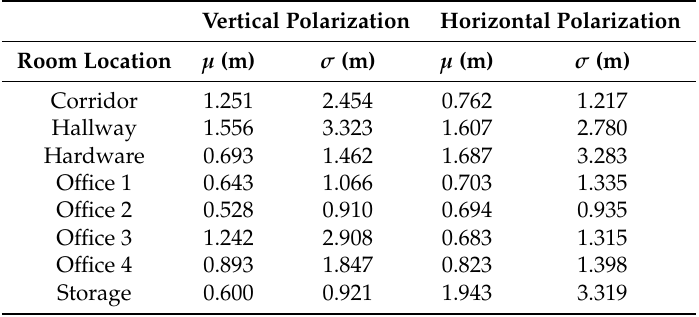
Figure 5. Localization performance of the proposed 3D CSI method when placing a TDVS receiver in each room of the simulated indoor environment for ( a ) vertical transmitter polarization and ( b ) horizontal transmitter polarization. Table 1. Localization performances of various TDVS antenna